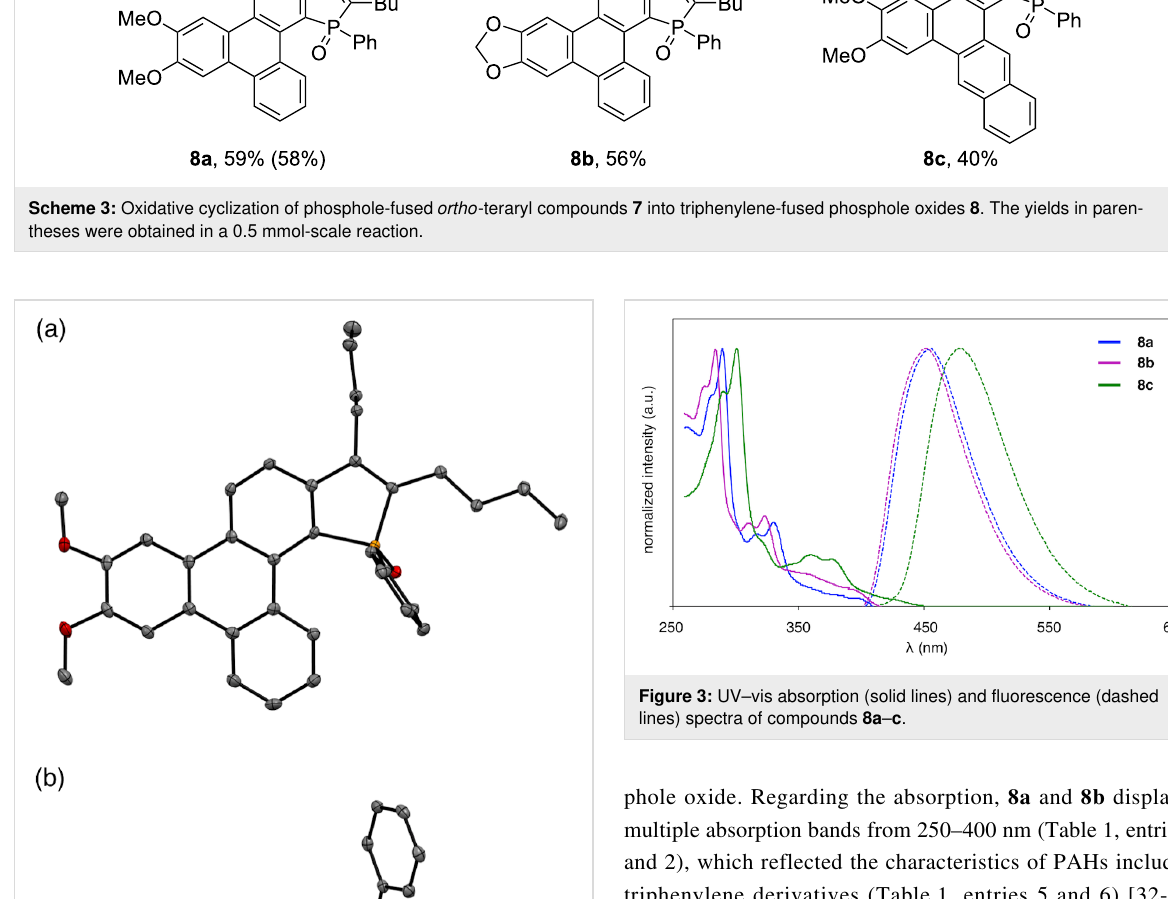
phole oxide. Regarding the absorption, 8a and 8b displayed multiple absorption bands from 250–400 nm (Table 1, entries 1 and 2), which reflected the characteristics of PAHs